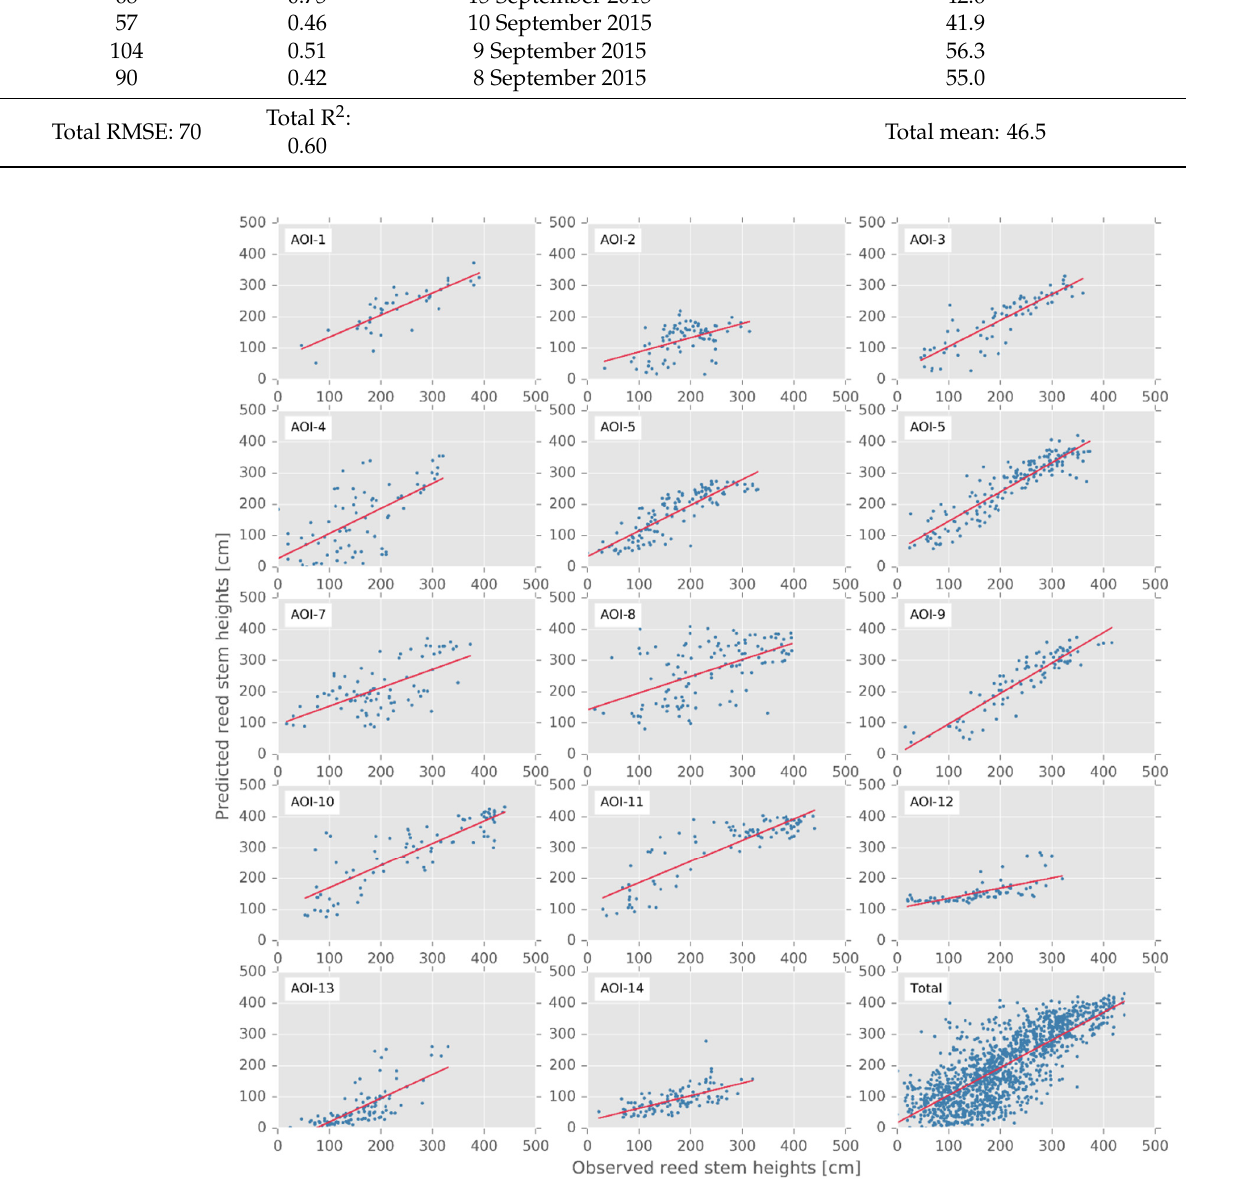
Figure 5. Comparison between in situ measured reed stem heights and 3K-data-predicted stem heights for every single AOI and in total.